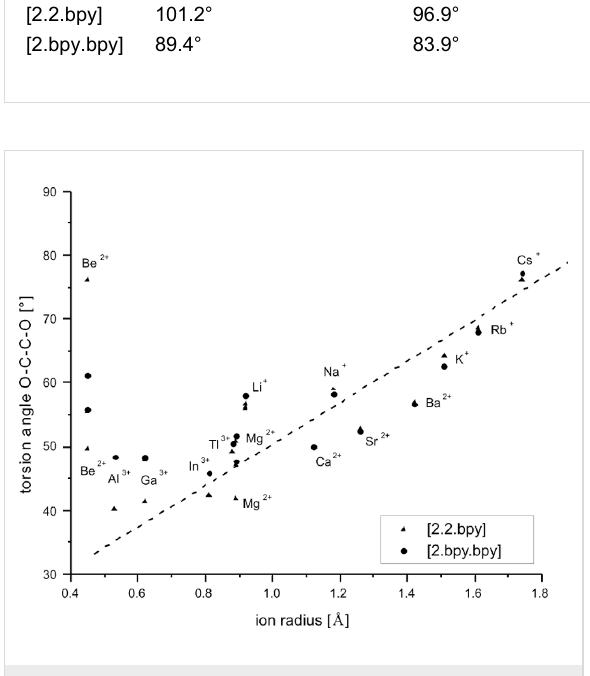
Figure 14: RB3LYP/LANL2DZp torsion angle O–C–C–O for [M 2.2.bpy] m+ and [M 2.bpy.bpy] m+ plotted against the ionic radius of M m+ (dashed line represents the observed